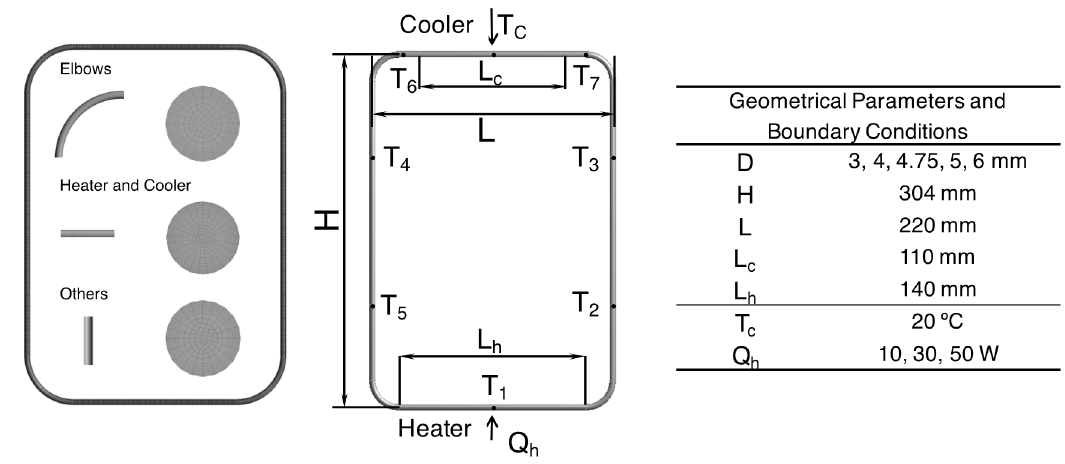
Figure 1. Schematic view of the 3D numerical model geometry, boundary conditions and dimensions.